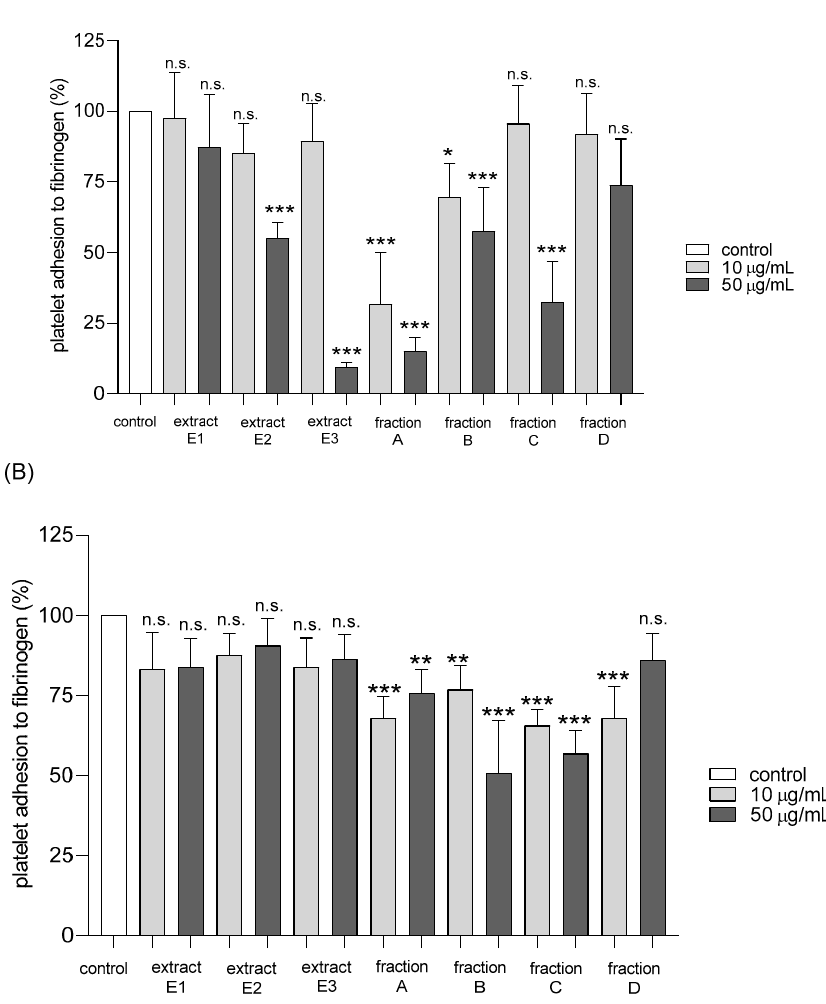
Figure 8. Effects of extracts (E1–E3) and flavonoid fractions (A–D) of dandelion fruits (concentrations 10 and 50 µg/mL) on adhesion to fibrinogen and ADP-activated platelets ( A ), and thrombin-activated